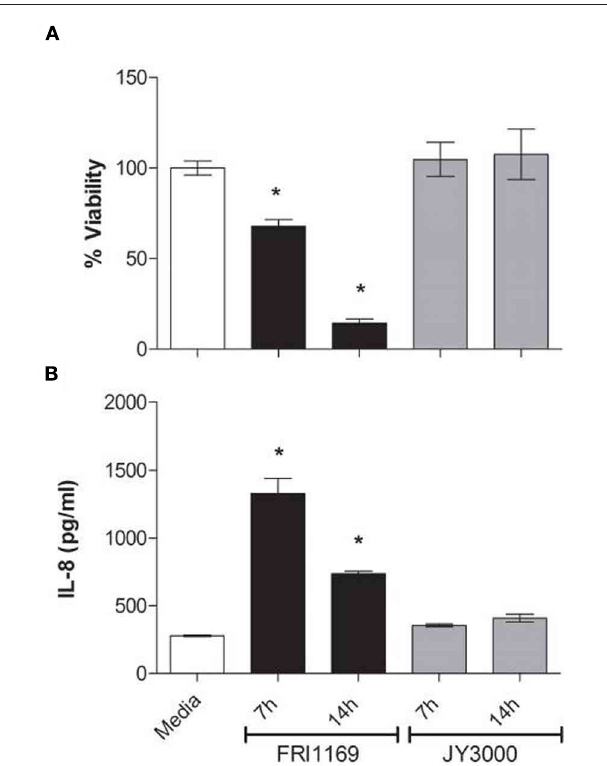
FIGURE 1 | In vitro comparison of wildtype FRI1169 and variant JY3000 cytotoxicity. A549 cell cytotoxicity (A) and IL-8 response (B) after 4h exposure to S. aureus broth culture supernates of FRI1169 (wildtype cytolytic) and JY3000 (biofilm-derived variant, non-cytolytic) grown for 7 or 14h. ∗ Indicates p < 0 . 05 compared to medium control (RPMI medium alone) by One-Way ANOVA, data plotted as mean ± standard deviation.